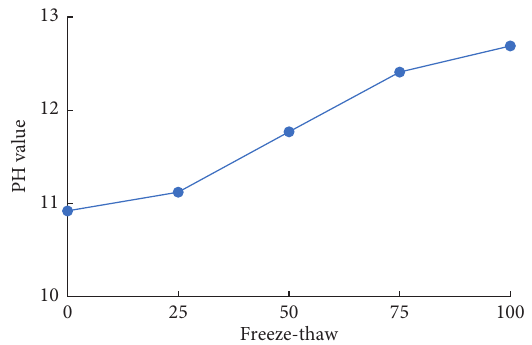
Figure 12: Changes of pH value in freeze-thaw environment.